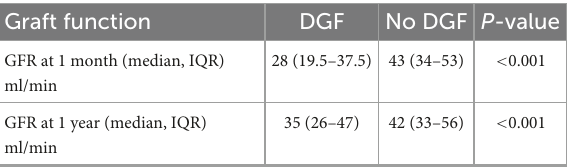
TABLE 4 Association of DGF and graft